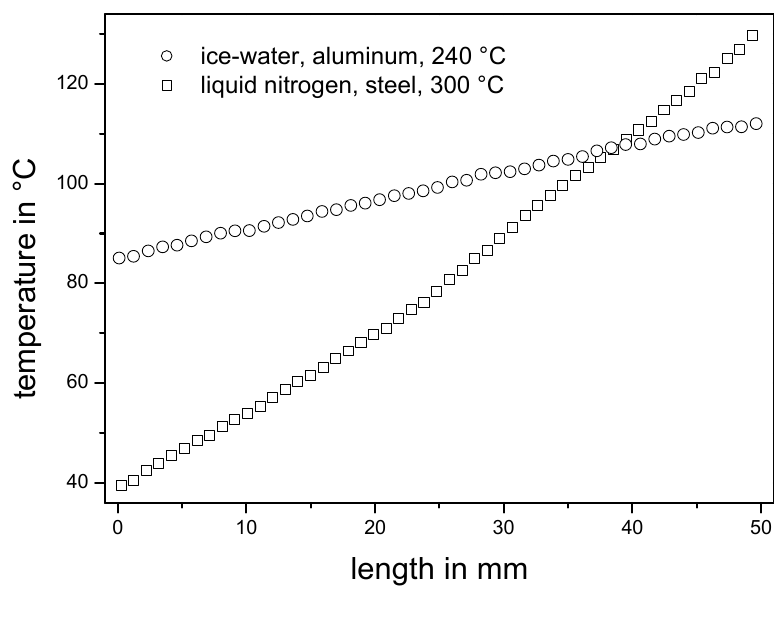
Figure 3. Two temperature profiles—measured using the reference silicon wafer—are shown utilizing different metal plates prepared over the length of 50 mm. The first temperature gradient (circles) was made on an aluminum plate cooling on the left side with ice-water and heating on the right side at the temperature of 240 °C. The achieved temperature gradient shows a steady slope of 0.55 °C/mm from 85 °C to 112 °C. The second (squares) was prepared under the conditions liquid nitrogen, steel plate and 300 °C. It shows an overall slope of 1.85 °C/mm from 39 °C to 130